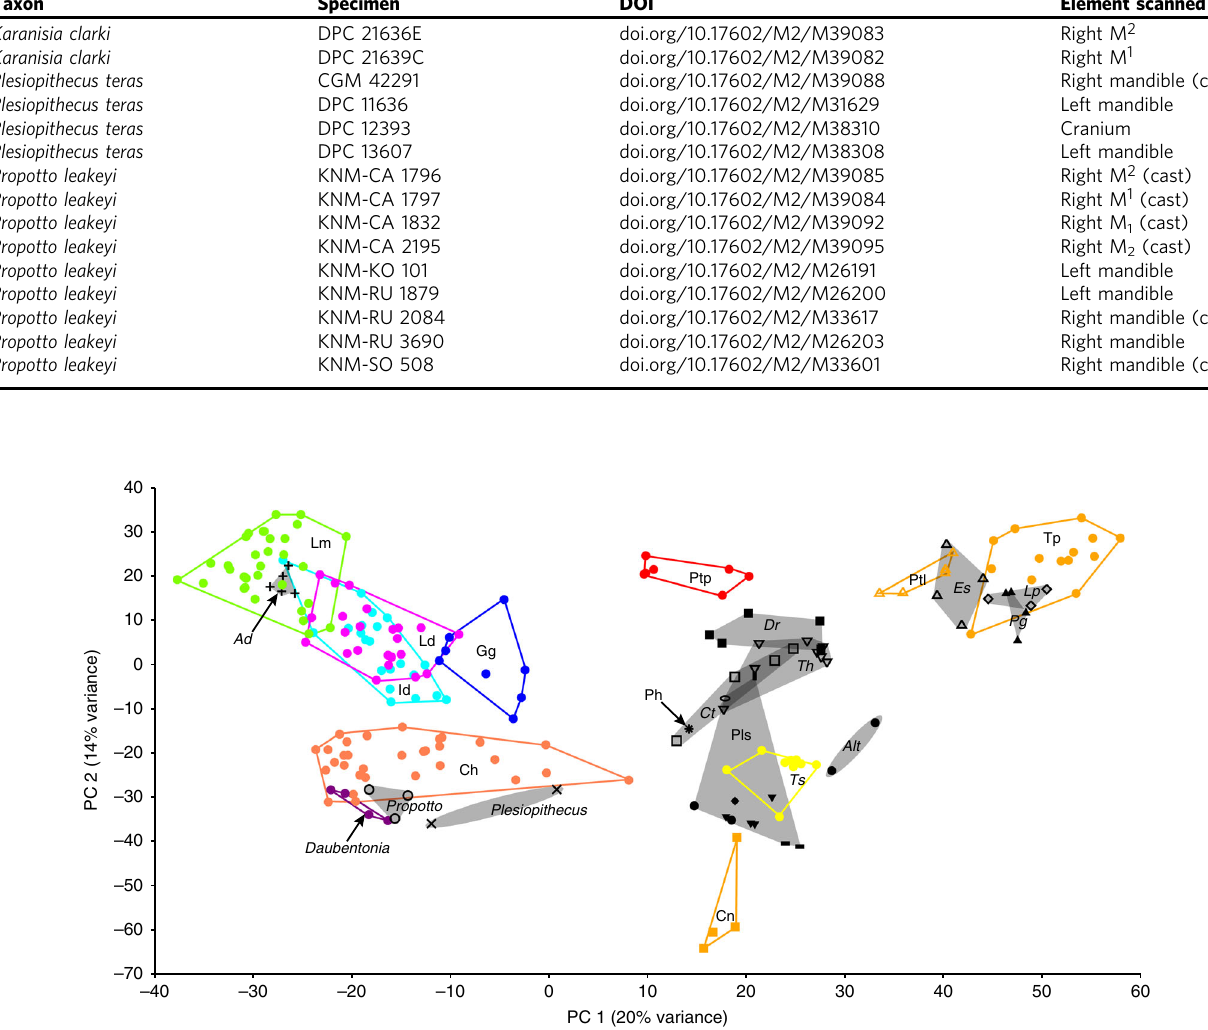
Fig. 3 First two principal components (PC) resulting from principal component analysis of 1100 pseudolandmarks on a broad taxonomic sample of second lower molar teeth. Each point represents the tooth of one individual. Convex hulls and different colors indicate distinct extant taxonomic groups. Gray hulls with different marker symbols represent different fossil taxa. This sample includes teeth of extant non-primate treeshrews (Ptl: Ptilocercus , Tp: Tupaia sp.), cynocephalid dermopterans (Cn), and pteropodid fruit bats (Ptp). It also includes fossil non-primates and possible stem primates including Leptacodon sp.